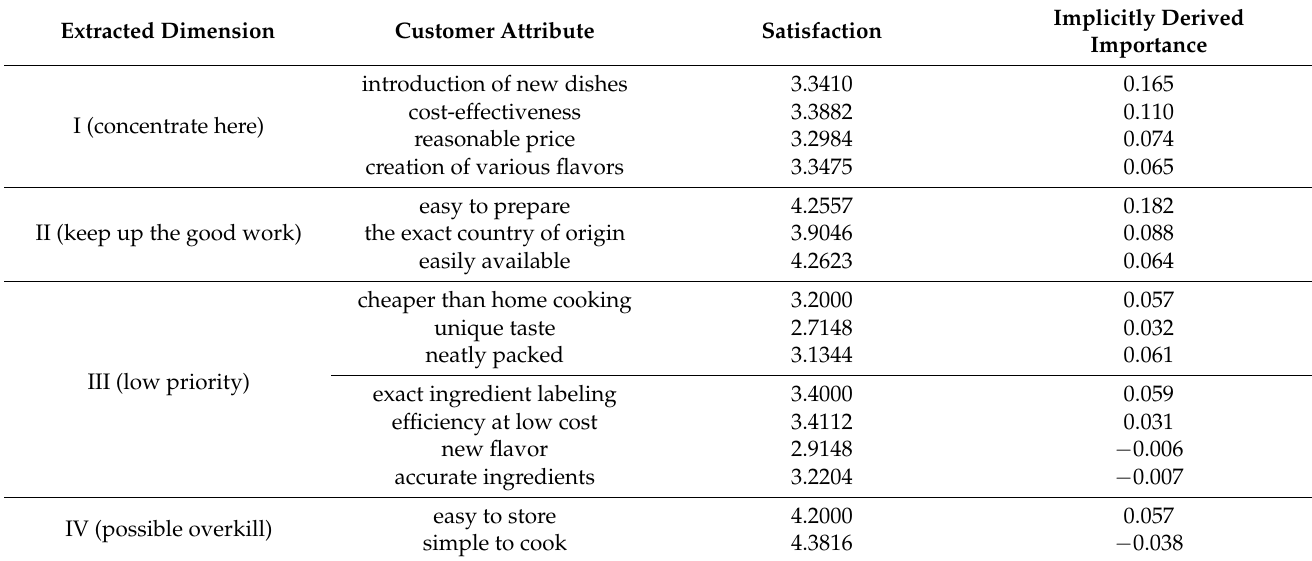
Table 6. Results of the modified